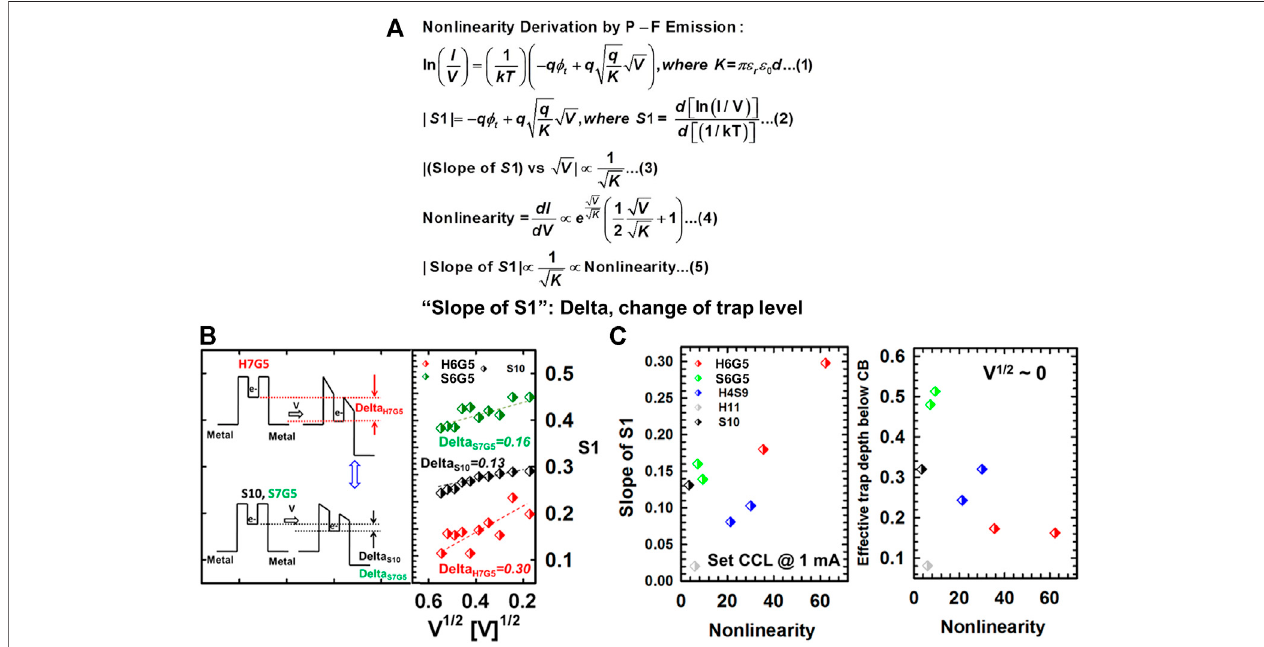
FIGURE 2 | (A) Summary of internal fi lament gap design by Poole – Frenkel formula in (Park et al., 2013) DC response, where B is a constant, q is the elementary charge, φ t is the energy barrier that must be overcome by the electron, ε r is the relative permittivity of the RS medium, d is dielectric thickness, k is the Boltzmann constant,andTistemperature.HuangandLee(2017);Liuetal.(2016)derivedtheprocedurefromPoole – Frenkelformula(Moonetal.,2018).Non-linearityde fi nitionand derivateprocedure(Sharmaetal.,2015).TherelationshipbetweenPoole – Frenkelcarriertransportandnon-linearity, (B) banddiagramofthetrap fl uctuationunder low (e.g., 0.28 V), and high voltage (e.g., 0.8 V) with the slope of S1 current fi tting results in H6G5, S6G5, and H11, (C) slope of S1 (left) and trap depth (right) as a function of non-linearity in fi ve device structures (SET CCL at 1